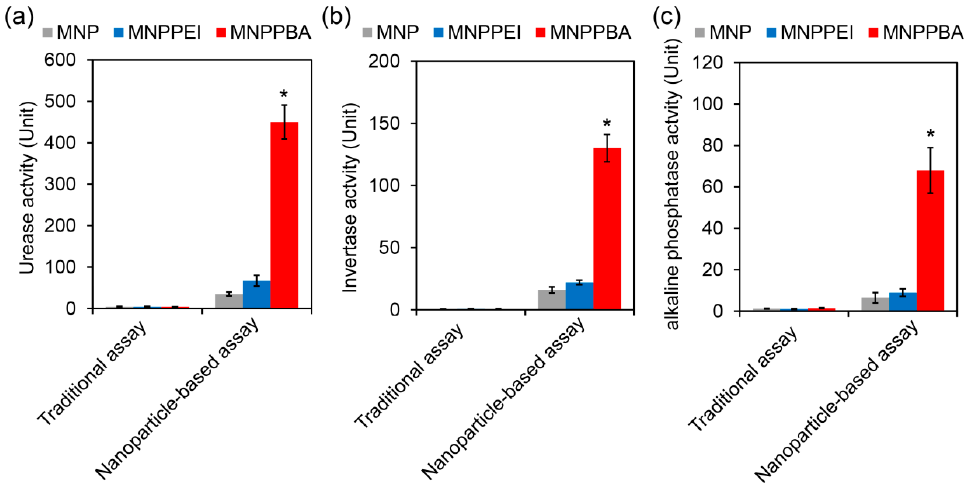
Figure 5. Enzyme activity of Amaranthus hypochondriacus rhizosphere soil supernatants detected by the traditional assay method and by the nanoparticle-based assay. ( a ) Urease activity. ( b ) Invertase activity. ( c ) Alkaline phosphatase activity. The asterisks (*) indicate a significant difference between MNPPBA and the other two groups ( p < 0.05).